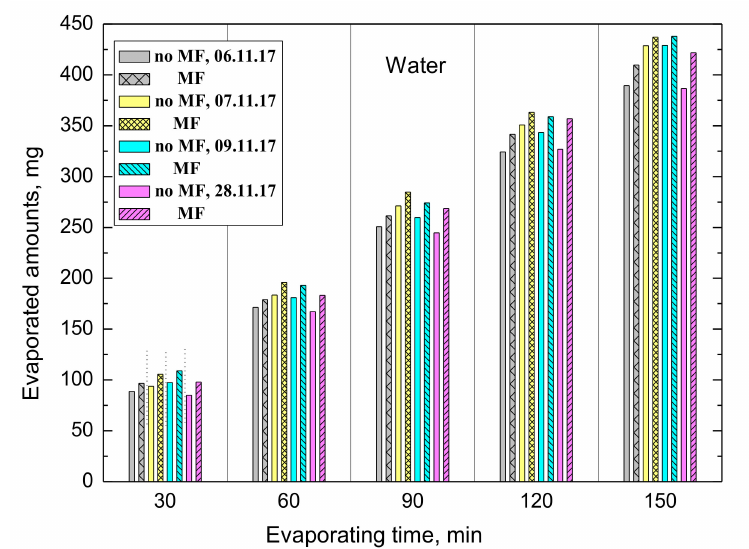
Figure 3. Evaporated amounts of water from the MF-treated and untreated samples.